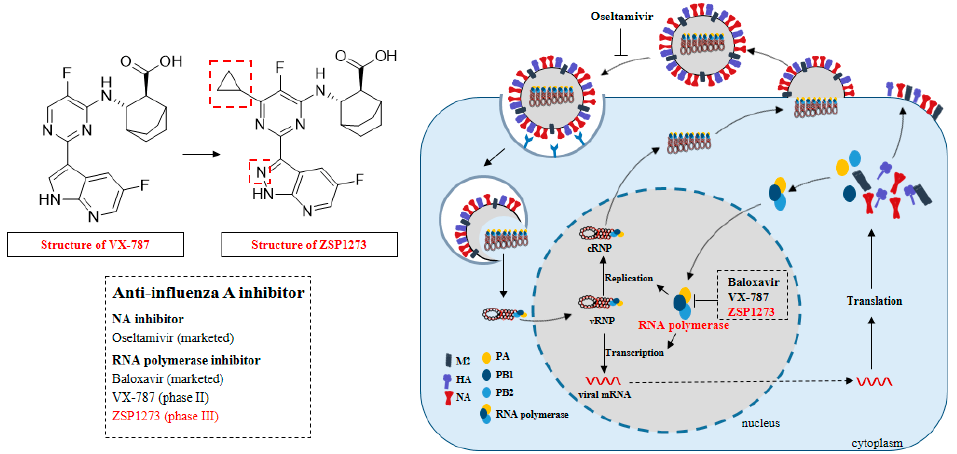
Figure 1. Therapeutic targets and small-molecule-targeted drugs for treatment of the influenza A